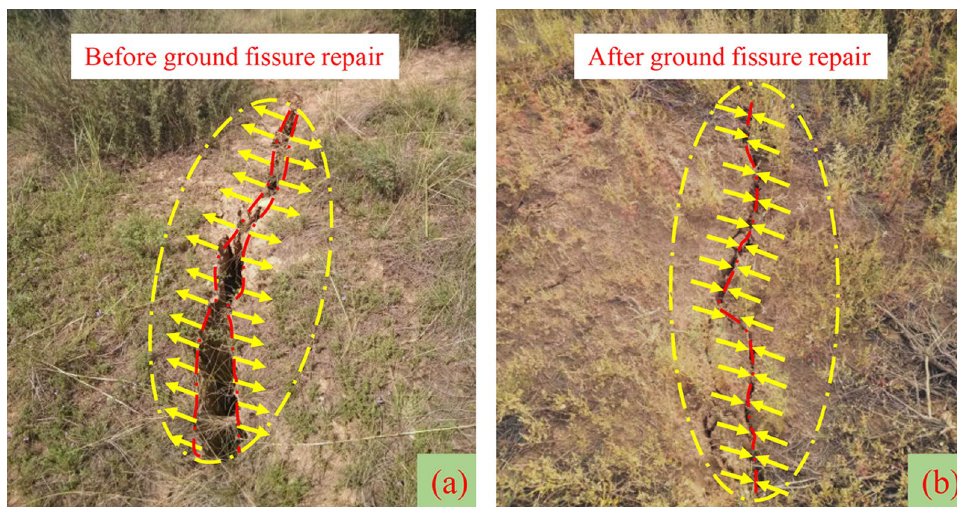
Figure 19. Ground fissure repair effect. ( a ) Before ground fissure repair. ( b ) After ground fissure